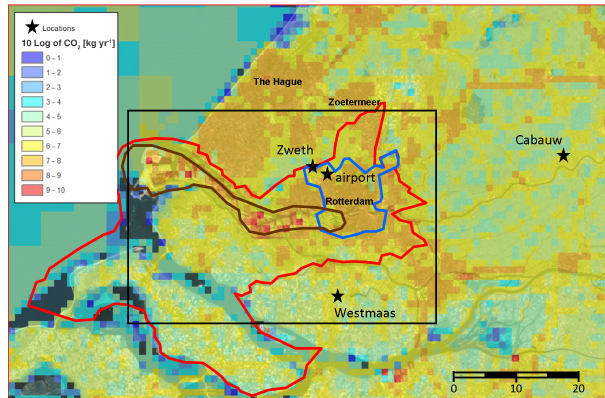
Figure 1. CO 2 emission map of the Rijnmond area (red outline), including the city of Rotterdam (blue outline) and the port area (brown outline); the observation sites are indicated with black stars (Lutjewad is shown in Fig. 2). The boundaries of domain 4 in WRF- Chem are indicated by the black square. Source: Netherlands PRTR